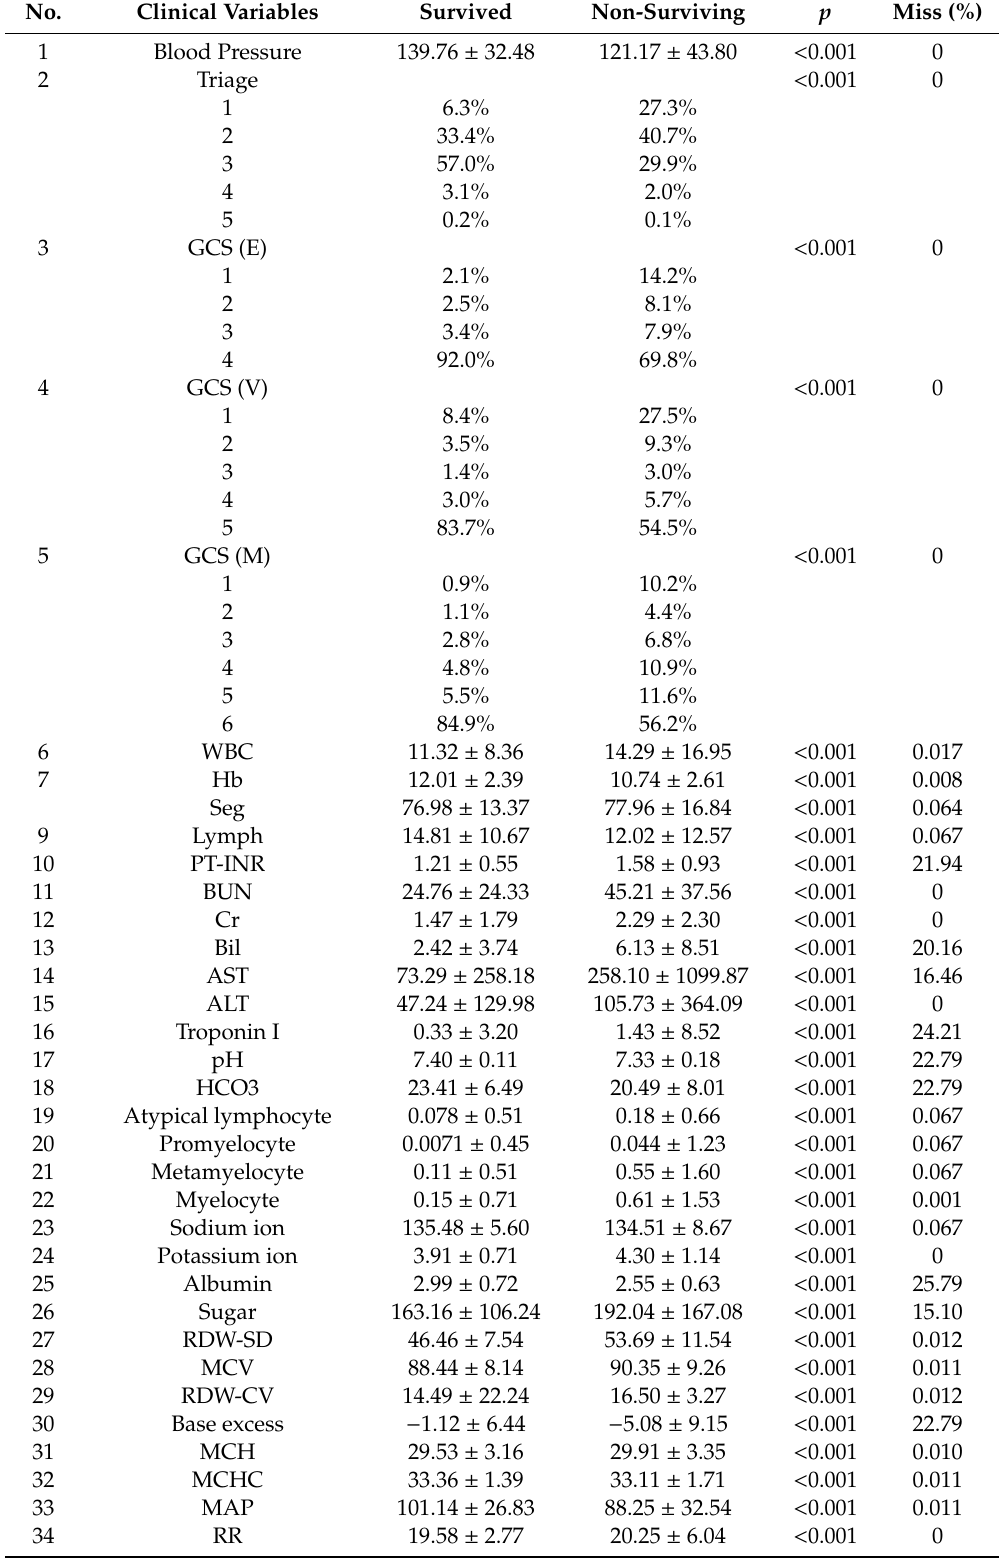
Table A1. Baseline features for machine learning (first reading on